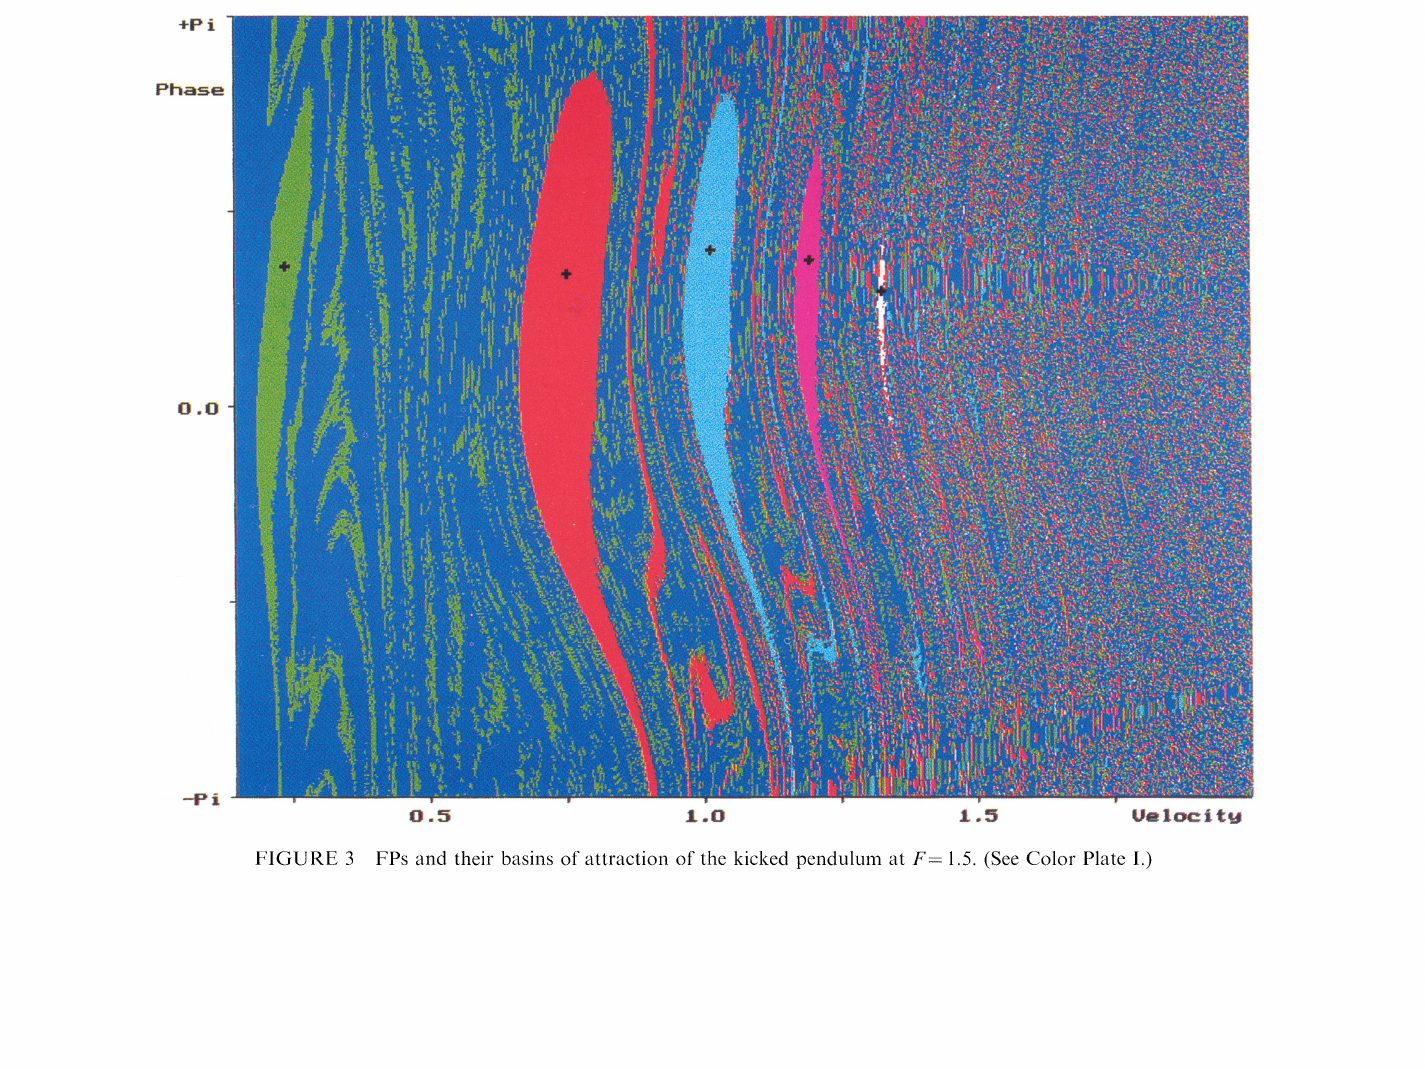
FIGURE 3 FPs and their basins of attraction of the kicked pendulum at F= 1.5. (See Color Plate